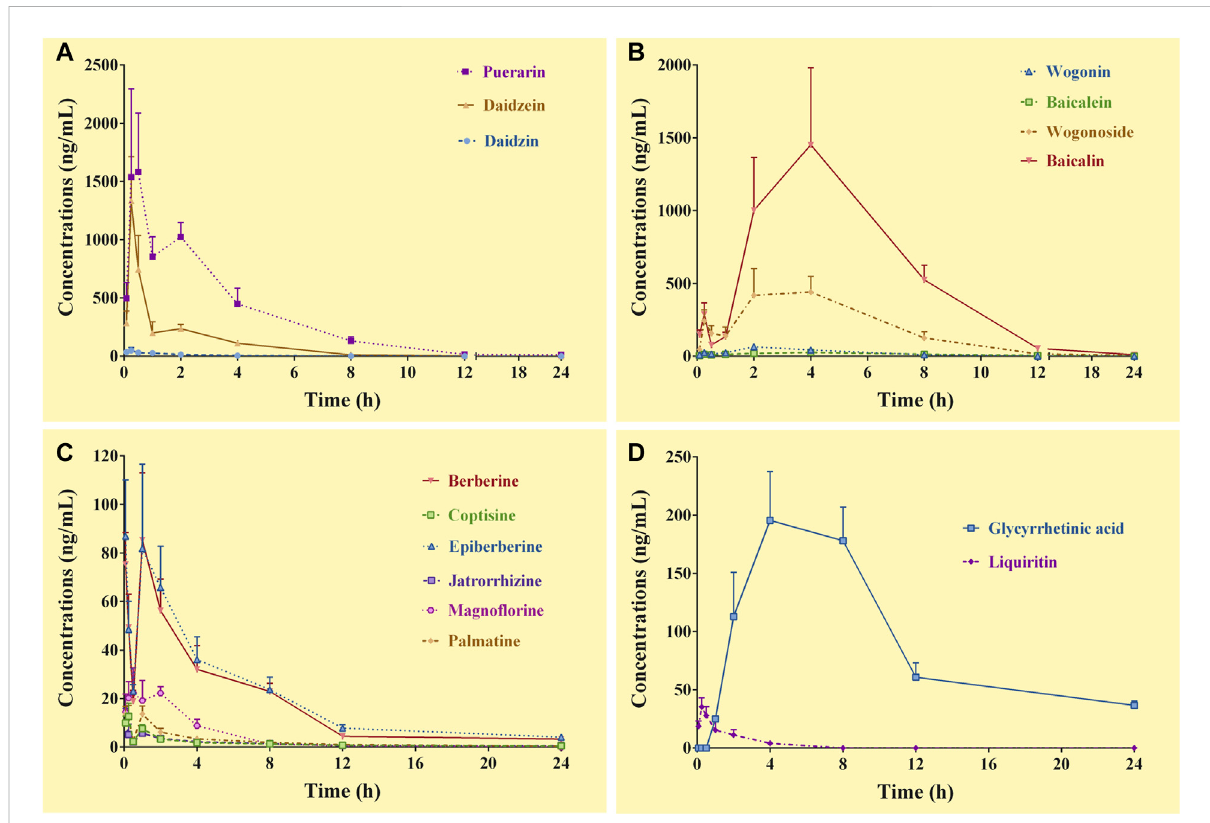
FIGURE 2 Concentration-time curves of the constituents of Gegen - Qinlian decoction in the systemic circulation of the mice received the oral Gegen - Qinlian decoctionatthedosageof6.1 g/kg(mean±SD,n=6). (A) ,constituentsderivedfrom PuerariaeLobataeRadix ; (B) ,constituentsderivedfrom Scutellariae Radix ; (C) , constituents derived from Coptidis Rhizoma ; (D) , constituents derived from Glycyrrhizae Radix Et Rhizoma Praeparata Cum Melle